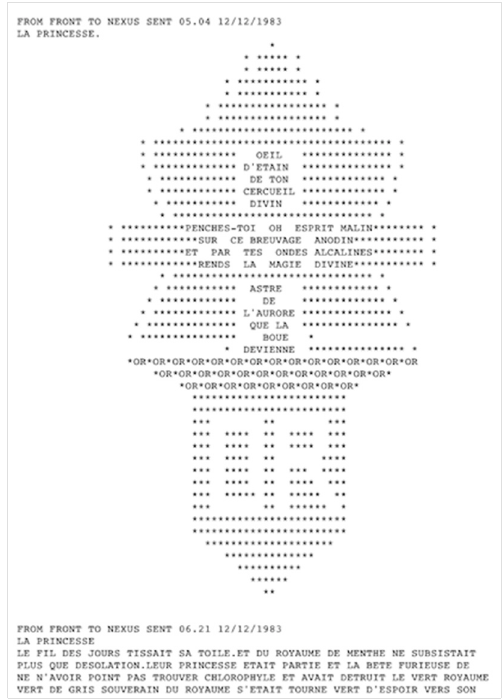
Figure 1. Roy Ascott, La Plissure du Texte , 1983. Screenshot of one participant’s contribution. © Media Art Net www.medienkunstnetz.de, 2019.